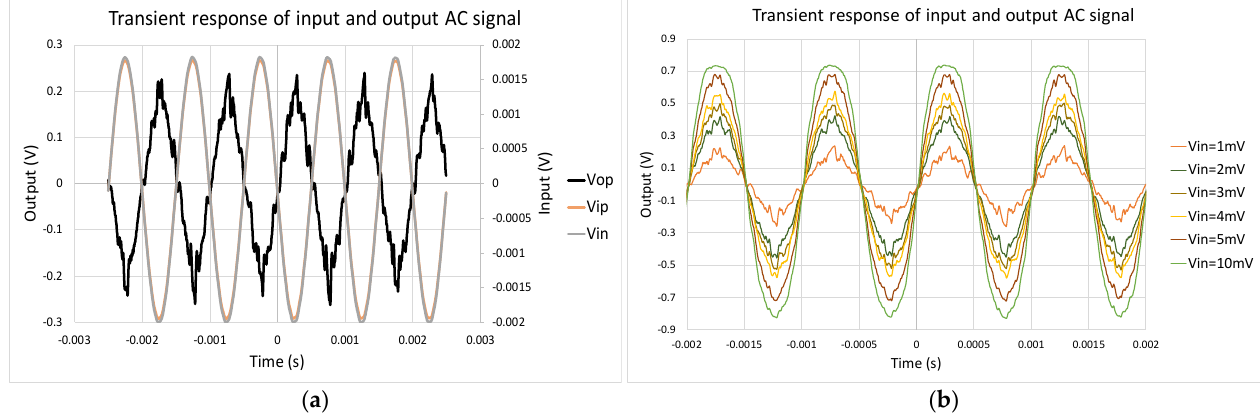
Figure 17. ( a ) Input and output signals under 1 kHz, 0.1 mVpp difference sinusoidal input; ( b ) output waveforms corresponding to increasing input at 1 kHz.